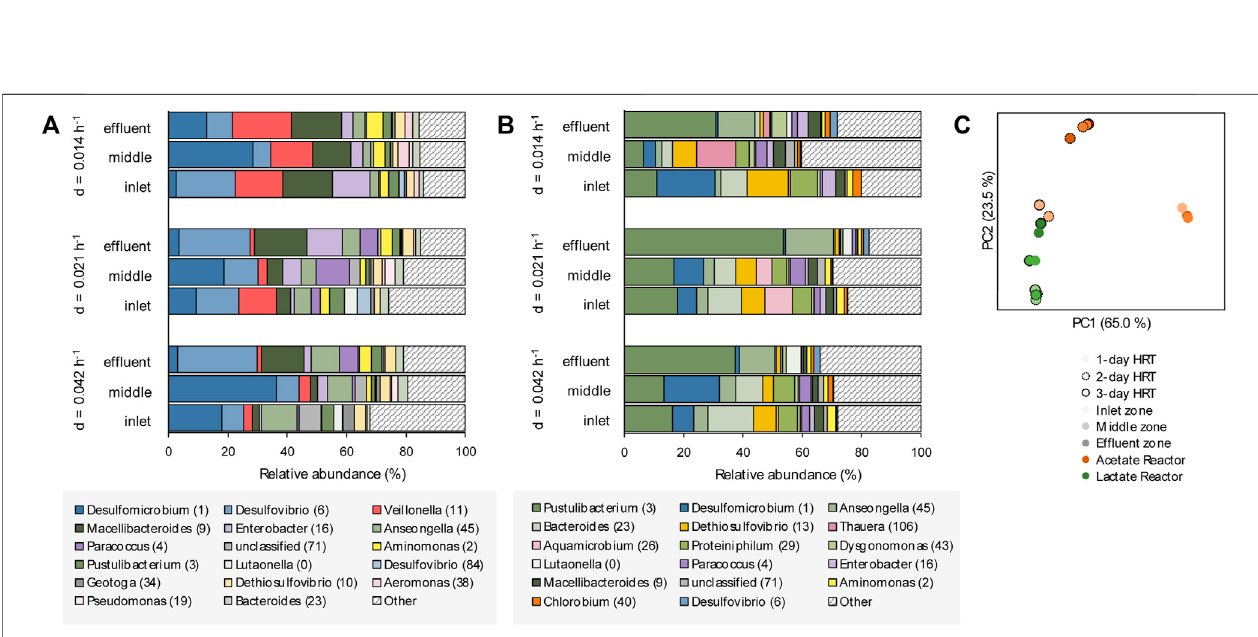
FIGURE 7 | The OTU composition of the planktonic communities of the inlet, middle and ef fl uent zones of the (A) lactate- and (B) acetate-supplemented UAPBRs isolated at steady-state at a dilution rate of 0.014, 0.021 and 0.042 h − 1 corresponding to HRT of three-, two- and one-day(s). OTUs are colour shaded by taxonomy: Thermodesulfobacteriota – blue, Pseudomonadota – purple, Bacteroidota – green, Bacillota – red, Synergistota – yellow, Chlorobiota – orange and other phyla – grey. (C) Principal component analysis based on weighted Unifrac distances assesses the beta-diversity between these planktonic communities at each HRT.